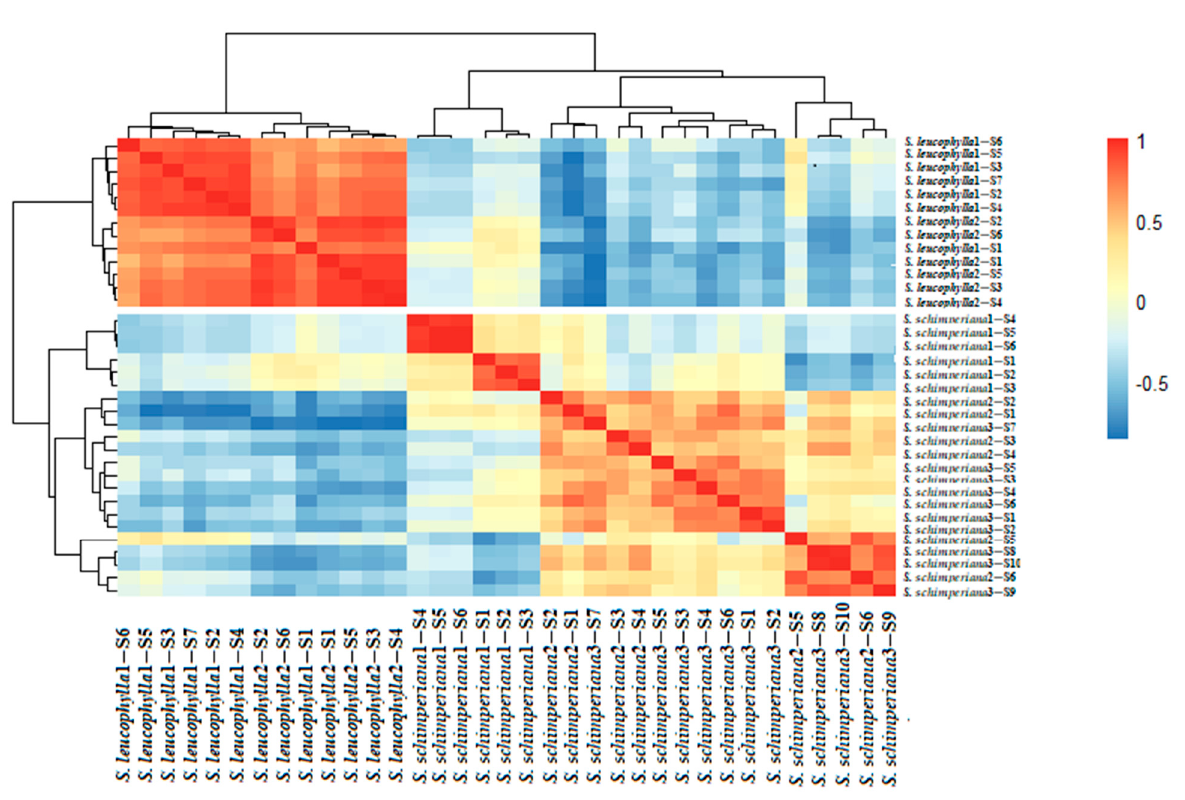
Figure 6. Pheatmap based on the quantitative data of stem and leaf micromorphological traits, showing the similarity and dissimilarity within and among Silene leucophylla and Silene schimperiana .